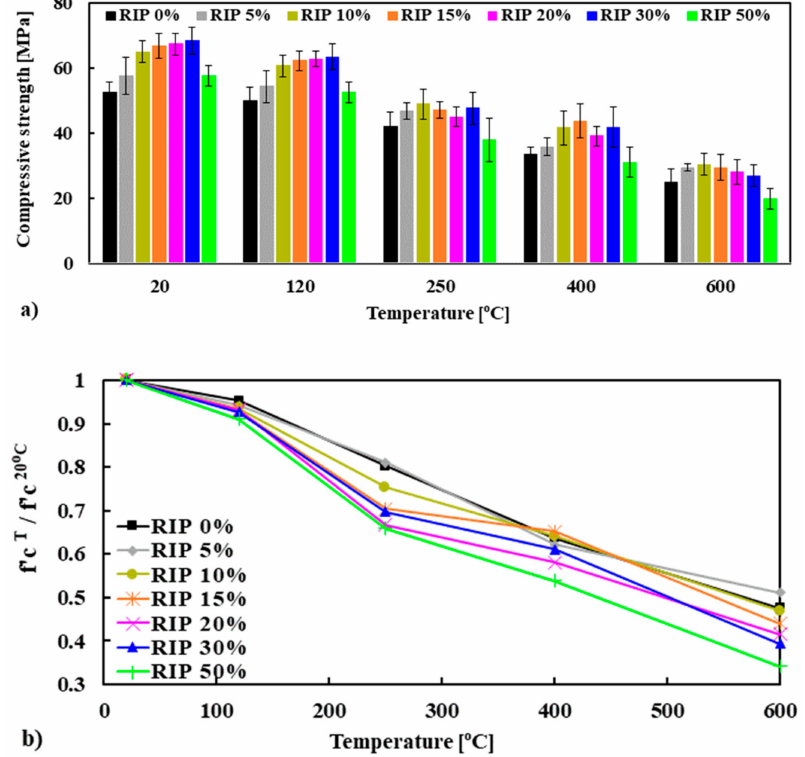
Figure12. Residual(f’c)( a )andnormalized(f’c)( b